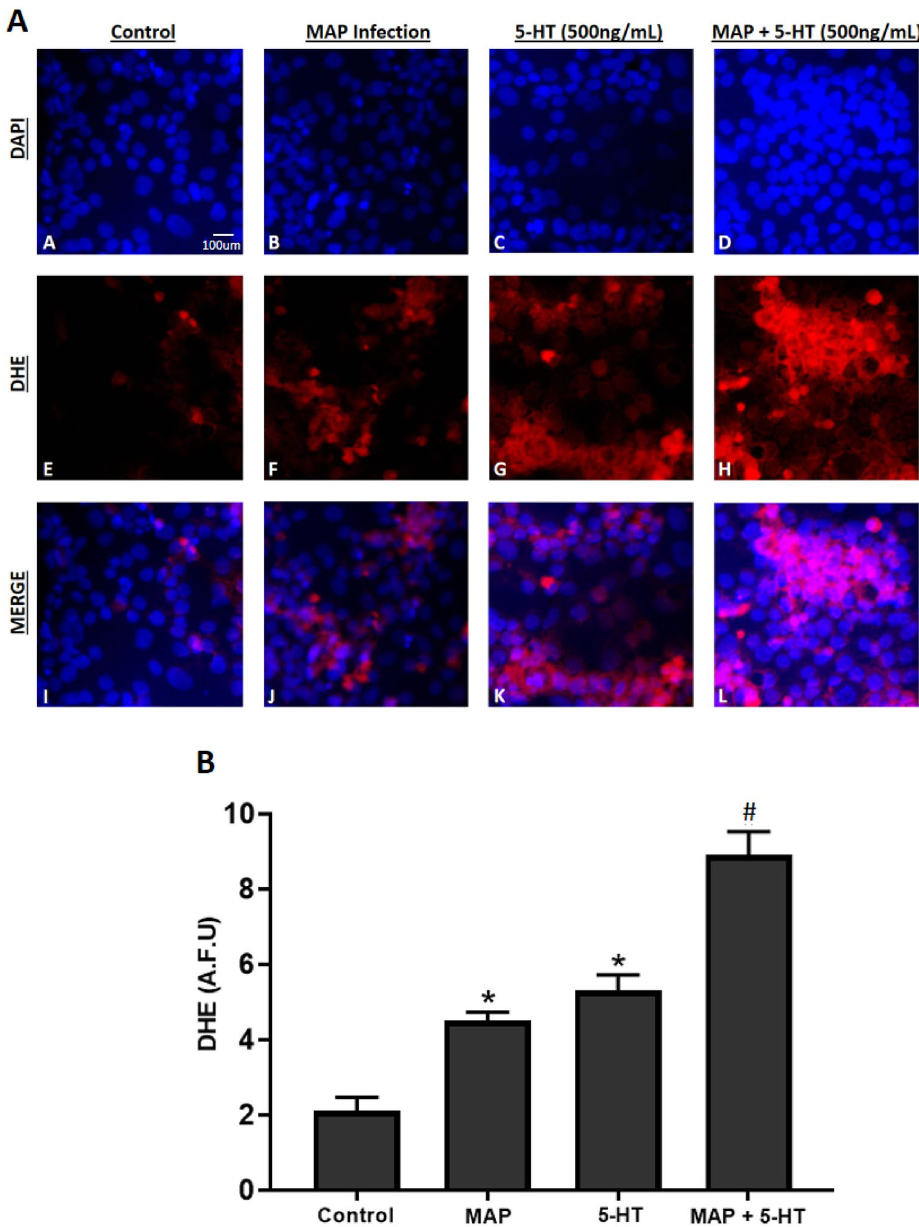
Figure 6. ( A ) Effect of MAP infection on oxidative stress level in Caco-2 monolayers in the presence of excess level (500 ng/mL) of 5-HT following 24 h of incubation. Total nuclei are stained with DAPI in blue ( A – D ). DHE positive cells are stained in red ( E – H ), and merged cells are presented in pink ( I – L ). ( B ) Quantitative corrected DHE fluorescence integrated density from control and treated groups. Values were pre-tested for normal distribution using the Kolmogorov–Smirnov normality test. Significance among experiments was assessed by two-way analysis of variance (ANOVA) followed by Bonferroni correction test. All DHE fluorescence staining experiments were performed in triplicates. Data are presented as Mean ± SD. * P value < 0.05 compared to no treatment control. # P value < 0.05 compared to no treatment control, MAP, and 5-HT